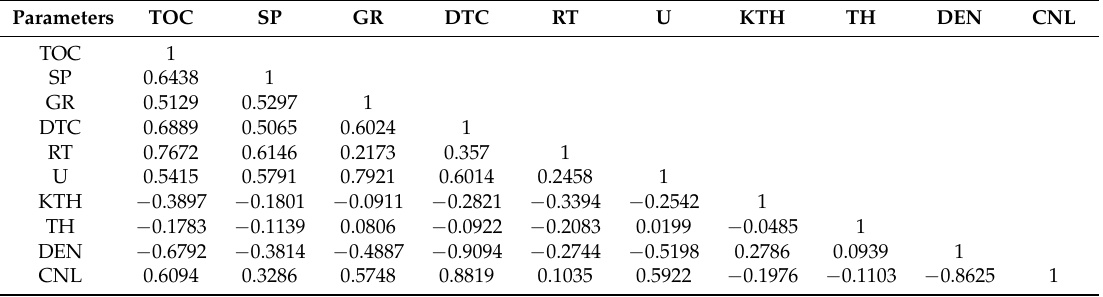
Table 6. Correlation matrix of Well E1 with sample data